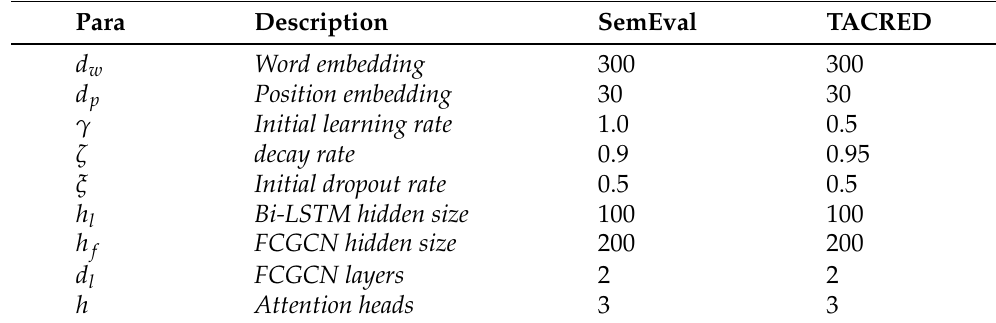
Table 1. Hyper-parameters used in the